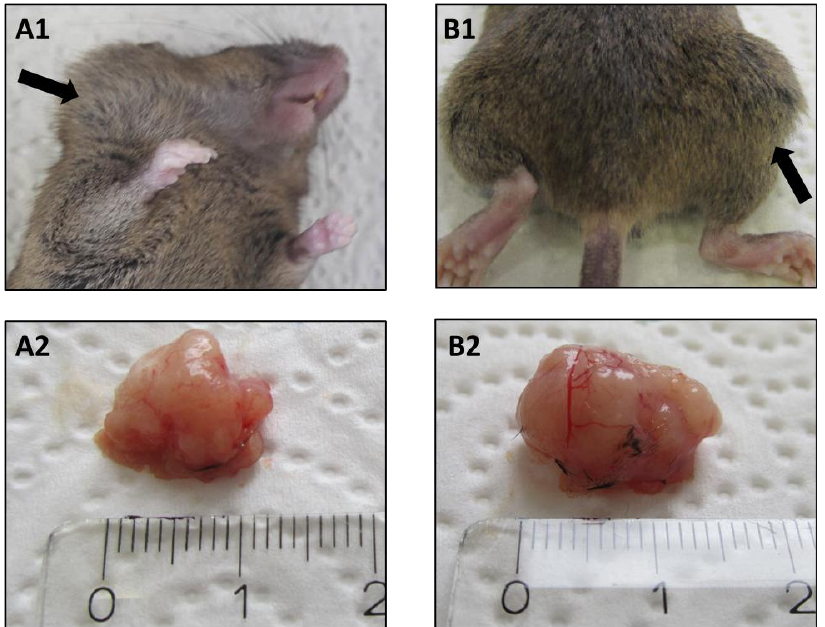
Figure 1. A representative example of an orthotopic tumor ( A1 , A2 ) and a subcutaneous tumor ( B1 , B2 ) grown for 21 days in a murine model (marked by black arrows). After preparation, both tumors are approximately 1 cm 3 in size 21 days after tumor induction ( A2 , B2 ). The attached length unit indicates the size in centimeters ( A2 , B2 ). Macroscopically, good vascularization of the tumor can be seen ( A2 , B2 ).